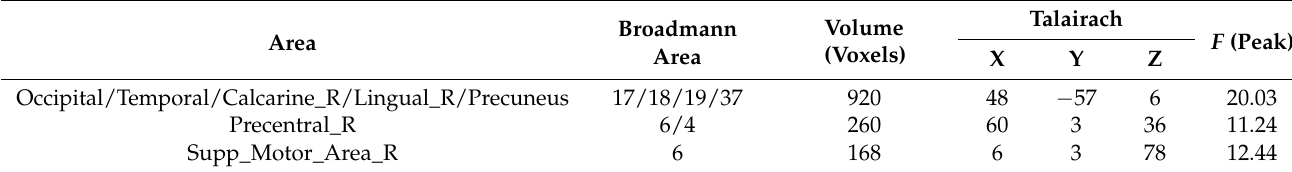
Table 3. Regional information of changed ALFF in repeat